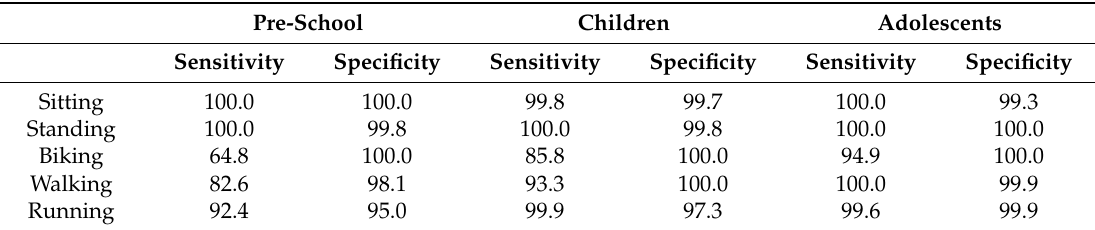
Table 2. Activity type identification accuracy for sitting, standing, biking, walking and running for the three age groups—preschool, children and adolescents—using the validation